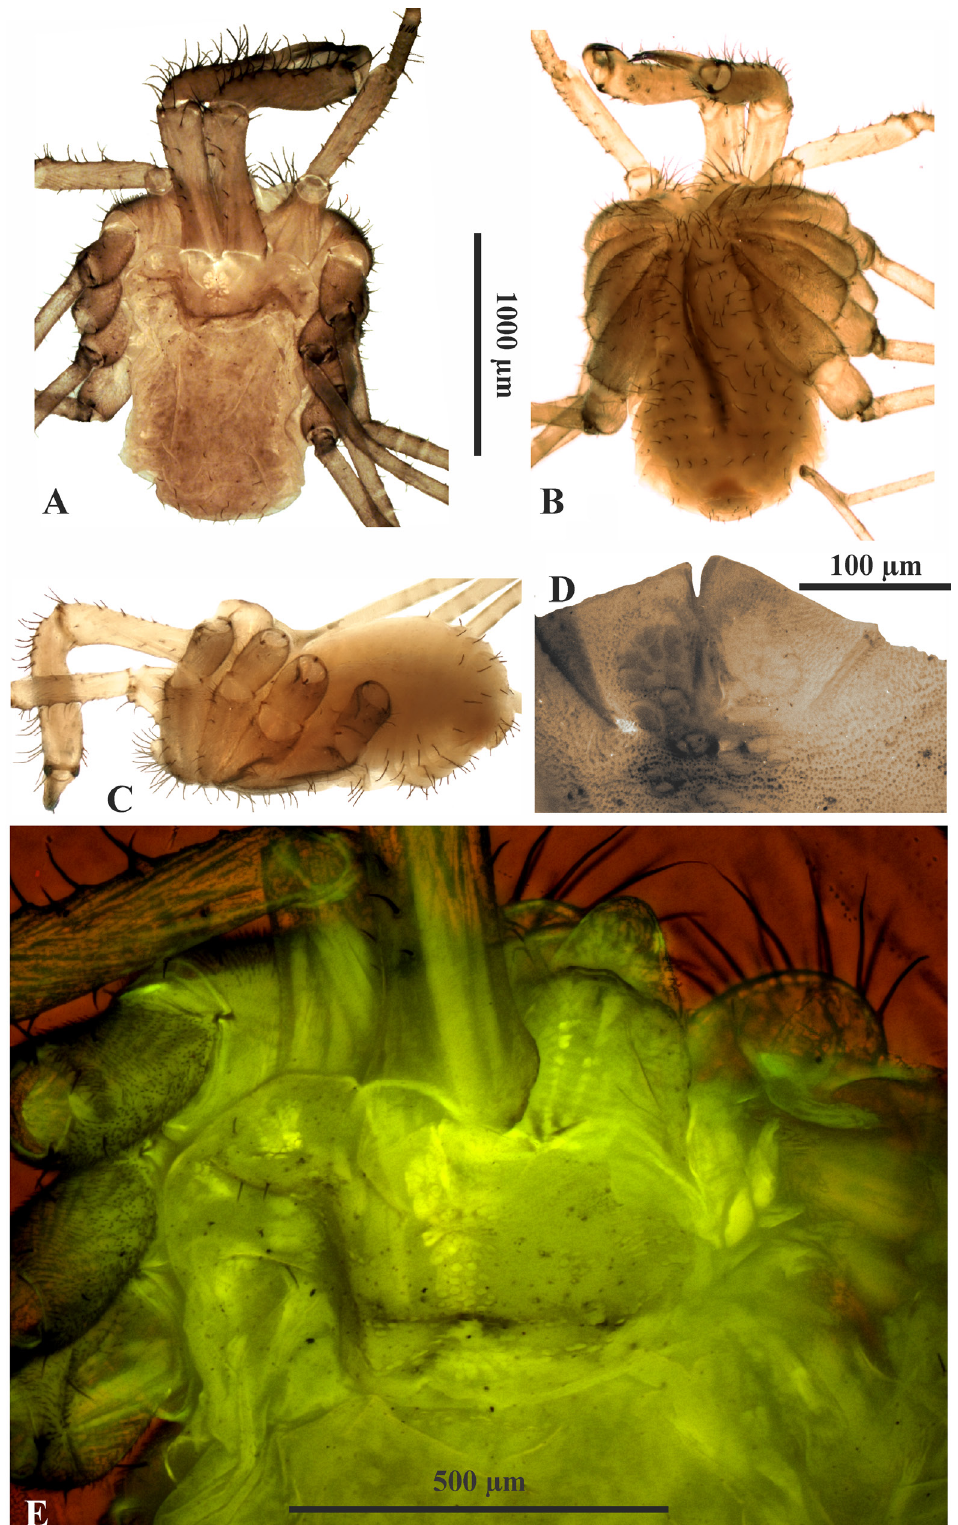
Fig. 1. Nemaspela borkoae sp. nov., ♂ holotype (PMSL-Opiliones-PK&TN 4/2019). A – C . Body, dorsal, ventral and lateral views (dry preparation). D . Supracheliceral lamellae. E . Body, dorsal view (fluorescence